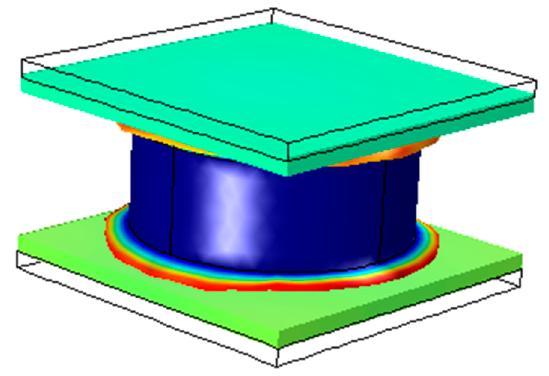
Figure 6. The displacement field corresponding to vibration mode B 8 .